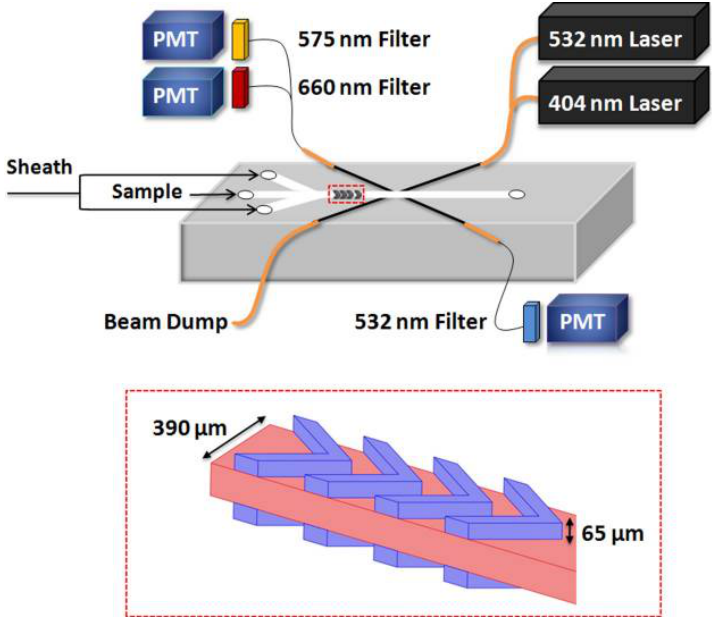
Figure 6. A schematic depiction of the proposed cytometer. (Top) The optical and microfluidics setup. (Bottom) A zoomed-in view showing the chevron grooves extending into the PDMS substrate. Reprinted with permission from [102]. Copyright 2011, AIP